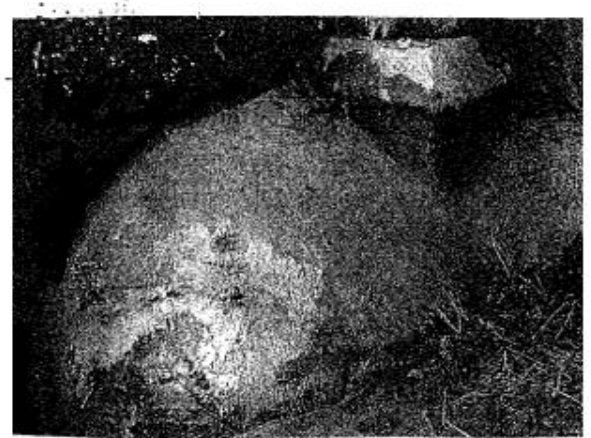
Figure 61. Photograph of the leftmost fractional ellipsoidal structure at the base of deep excavation pit. Photo by